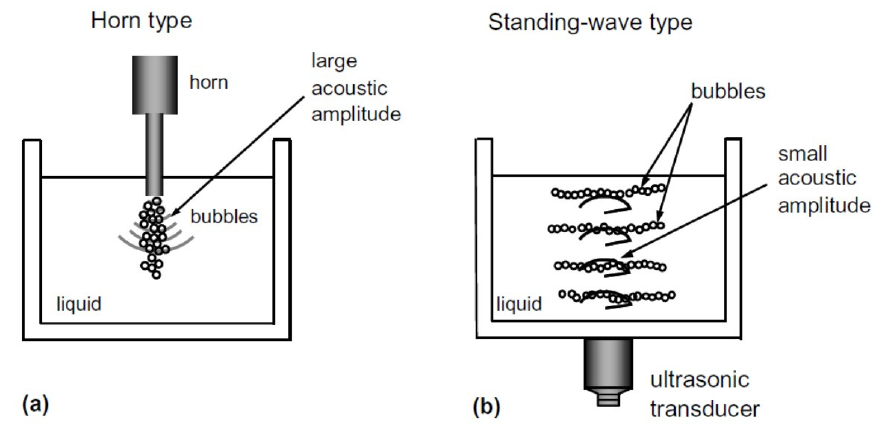
Figure 11. Two types of sonochemical reactors [33]. ( a ) A horn-type reactor. ( b ) A standing-wave type reactor. Copyright 2005, with the permission from Elsevier.